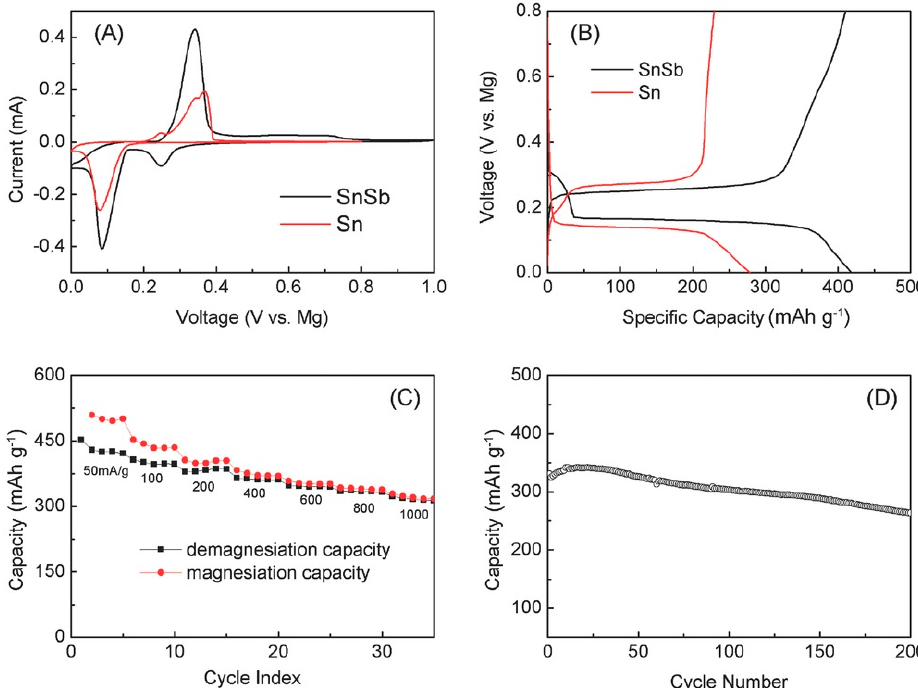
Figure 9. Comparison of electrochemical behaviour of tin–antimony alloy and tin towards magnesiation/de-magnesiation: ( A ) CV carried out at 0.05 mV s − 1 ; ( B ) Charge–discharge profiles at 50 mA g − 1 ; ( C ) Specific capacity at different current densities when using the tin–antimony alloy; ( D ) Cycling stability of the tin–antimony alloy at 500 mA g − 1 . Adapted with permission from [167]. Copyright American Chemical Society, 2015.